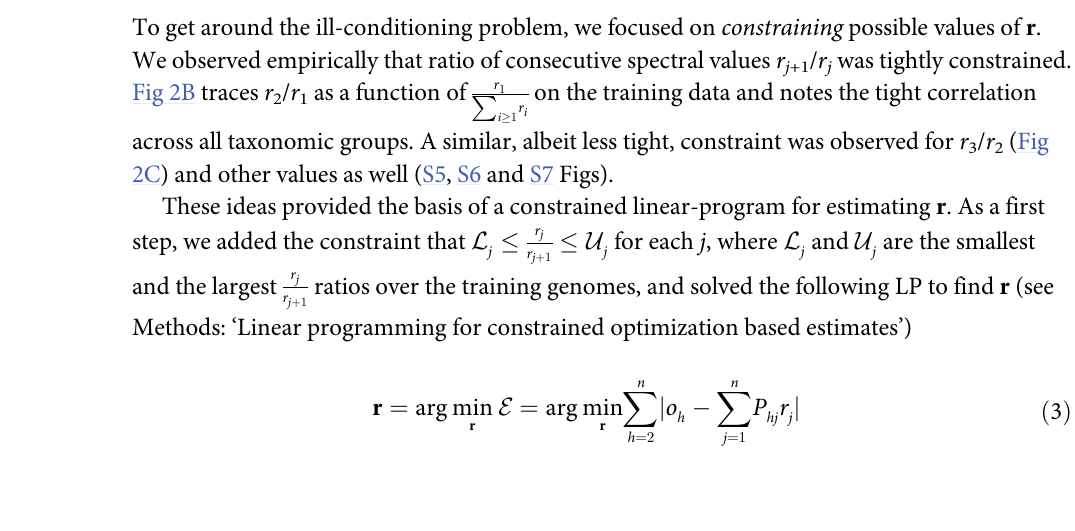
. In both B and C, true spectral ratios on i =2 r i